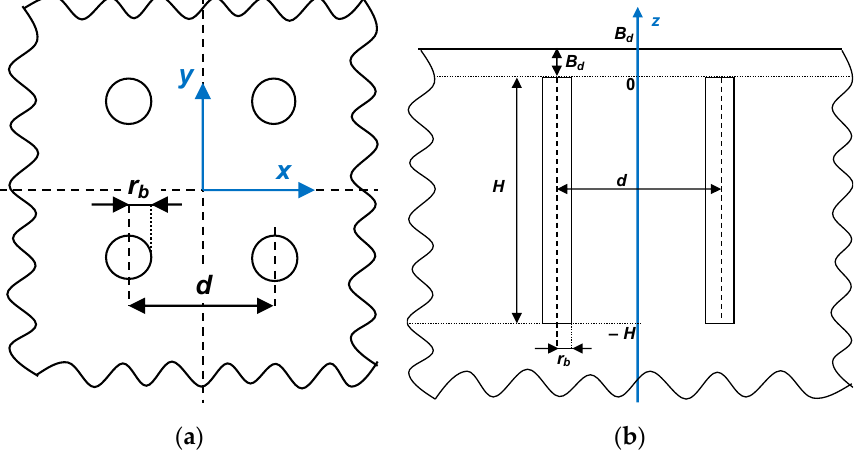
Figure 4. ( a ) Horizontal view of the 2 × 2 borefield; ( b ) Vertical view of the 2 × 2 borefield.